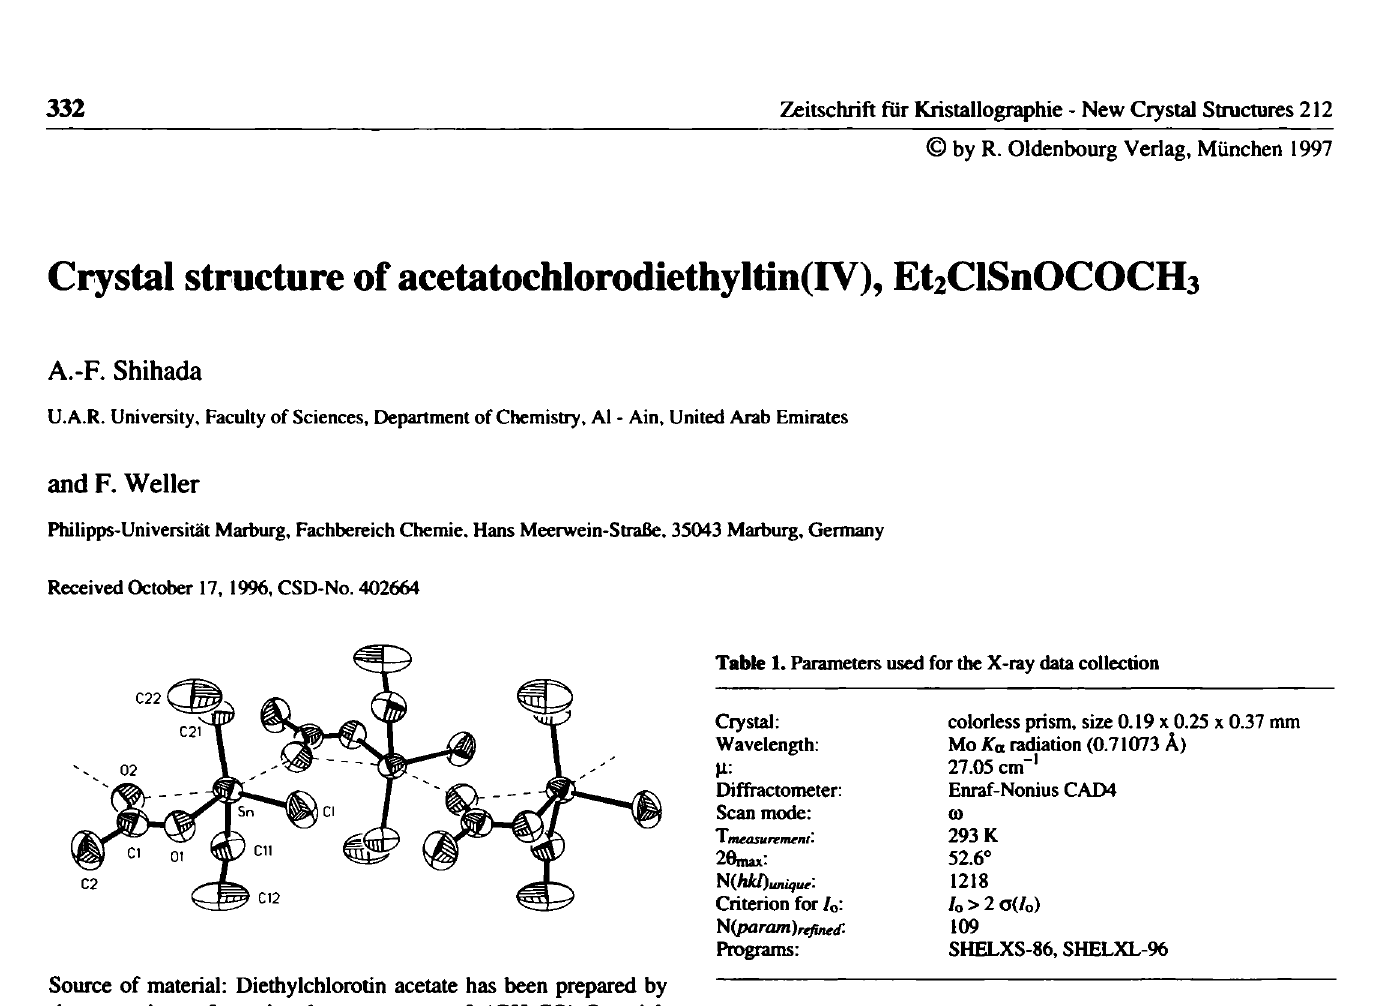
Table 2. Final atomic coordinates and displacement parameters (in Â 2